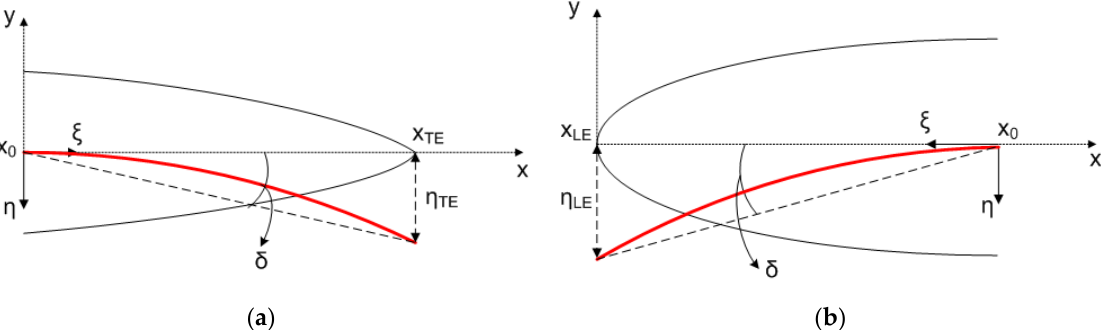
Figure A1. Definition of the baseline deformation at the ( a ) TE region and ( b ) LE region. The thick red line represents the deformed mean line.